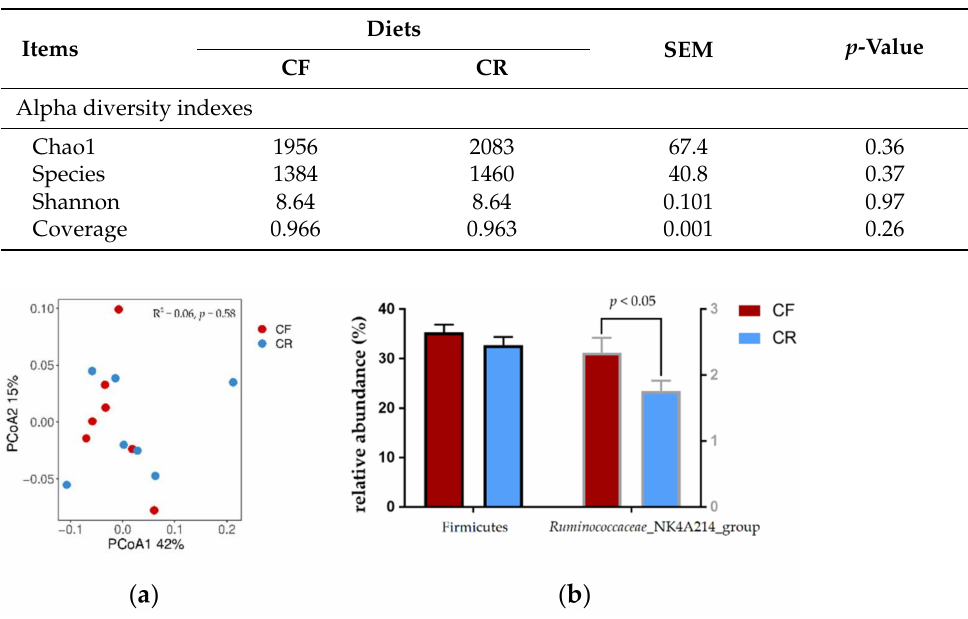
Table 8. Alpha diversity indexes of bacterial community, as determined by 16S rRNA gene sequencing in the rumen content of beef cattle fed corn stover after fresh-corn harvested (CF) or corn stover after ripe-corn harvested (CR) silage diet (n = 7).